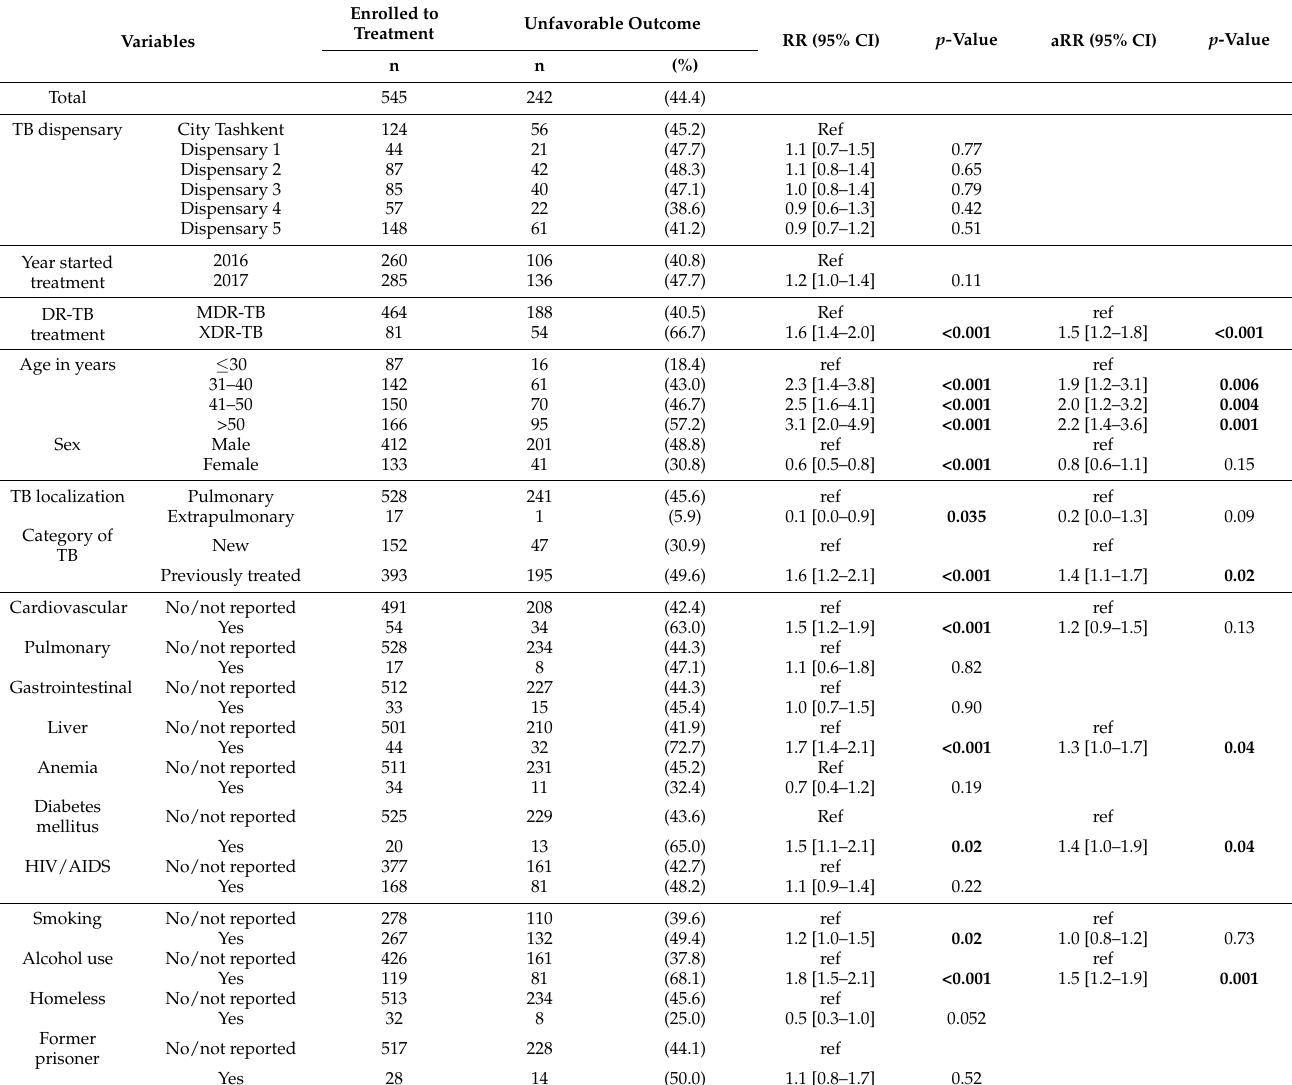
Table 3. Risk factors for unfavorable treatment outcomes in patients with TB enrolled in MDR-TB and XDR-TB treatment in Tashkent city, Uzbekistan,